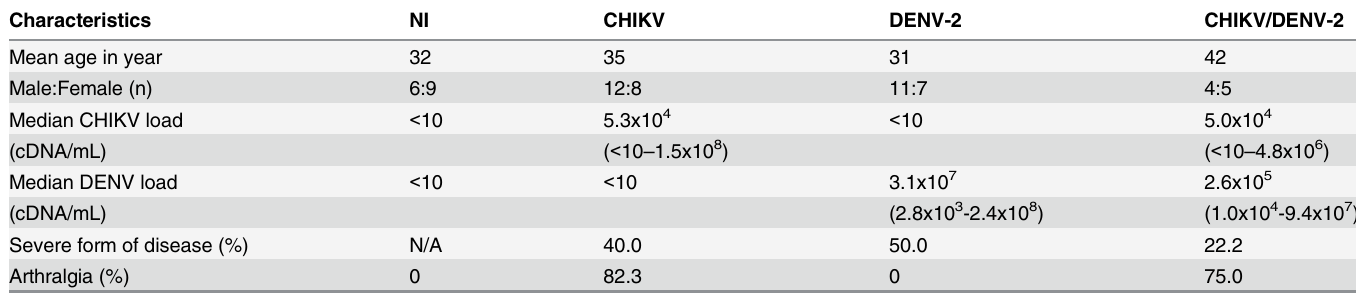
Table 1. Characteristics of healthy donors and